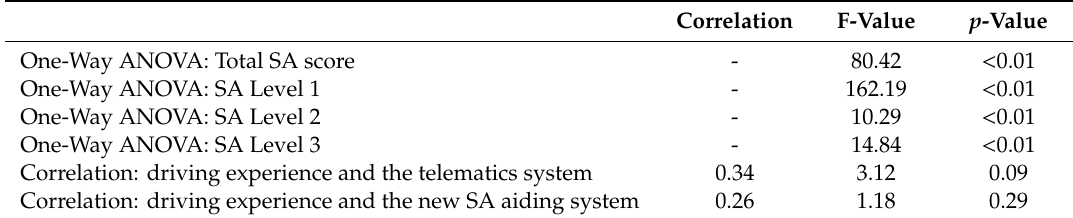
Table 3. The statistical analysis of SA scores: One-way ANOVA and the correlation (Source: Own